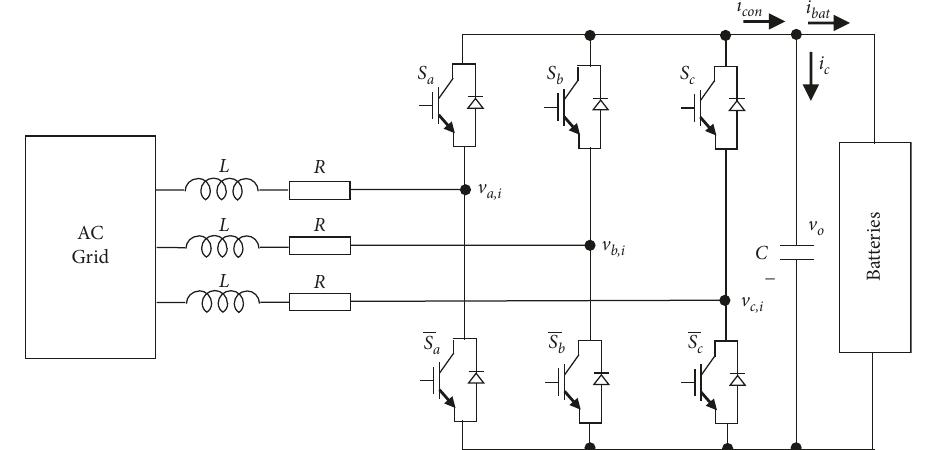
Figure 1: Three-phase bidirectional charger with